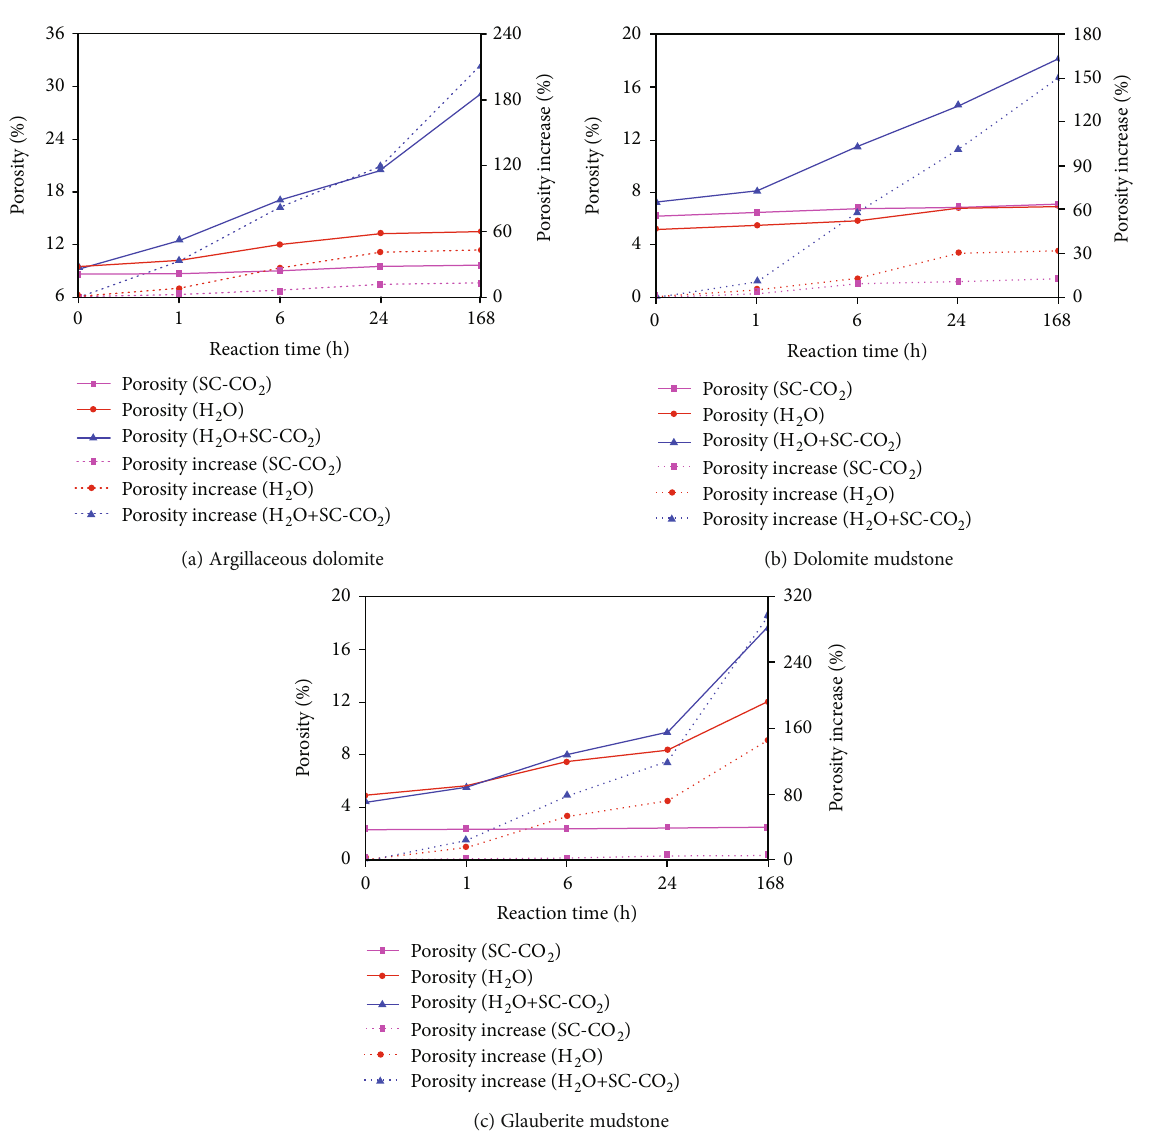
Figure 7: Change of porosity after immersion in fl uid at di ff erent